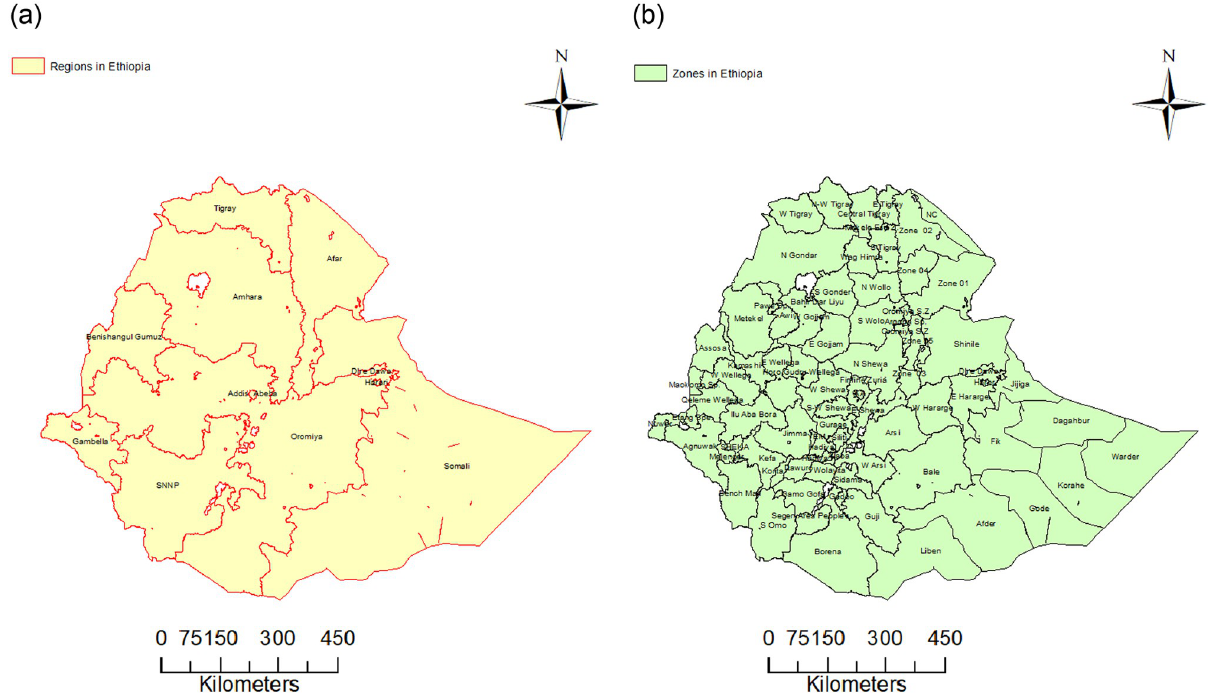
Fig 1. Regions and Zones in Ethiopia. Spatial plot of regions and zones in Ethiopia, where E, N, S, W, N-W, Sp. and Z represent east, noth, south, west, north-west, special and zone, respectively.